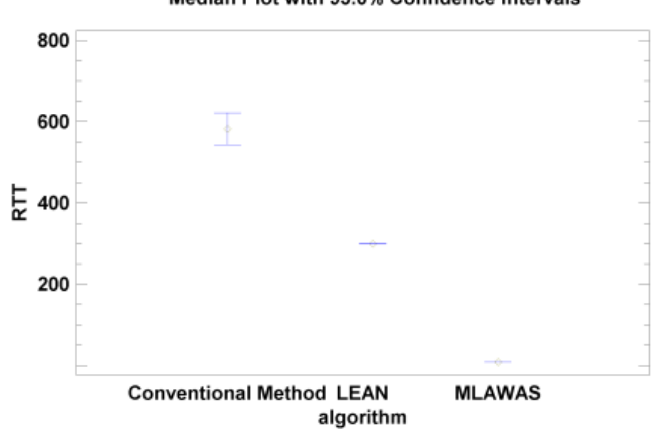
Figure 9. Migration Delay of Workload from Cloudlet to Cloud.